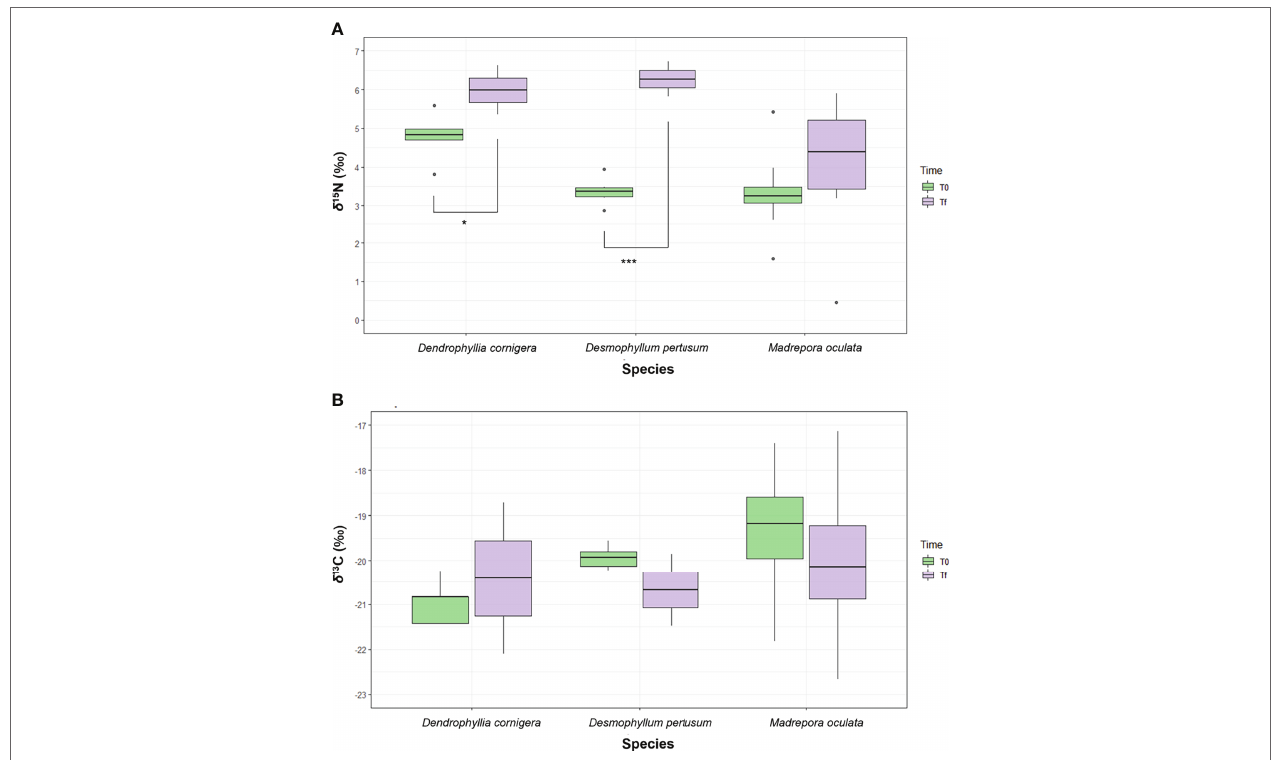
FIGURE 2 | Boxplots showing the values of δ 15 N (A) and δ 13 C (B) of the specimens of corals used in the experiment at T 0 (green boxes) and T f (violet boxes) with significant differences indicated by the stars. The horizontal line within the box represents the median, the boundaries of the boxes represent the first and second quartiles and the whiskers of the boxes represent the 95 % credibility interval. *p<0.05;